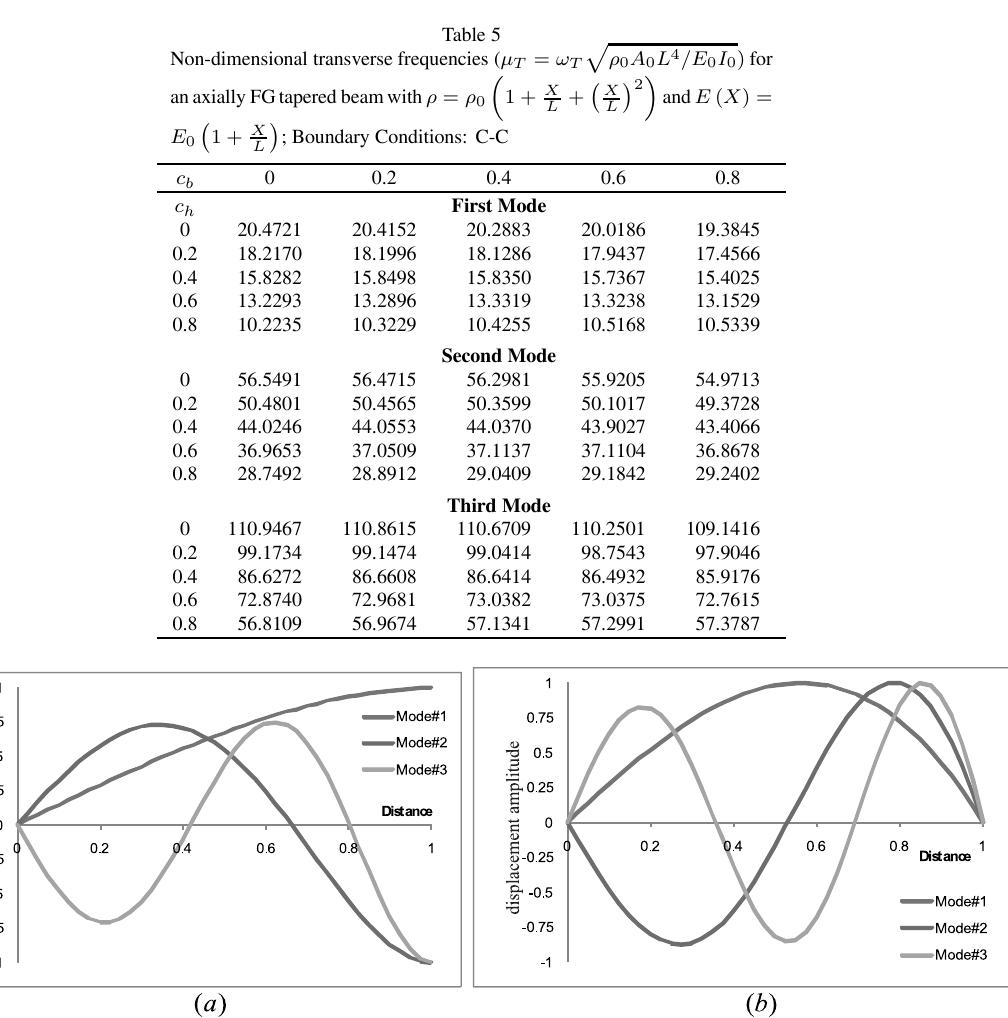
Fig. 3. The fi rst three mode shapes of an axially FG tapered rod with c h = 0 and c b = 0 . 8 for (a) C-F and (b) C-C boundary